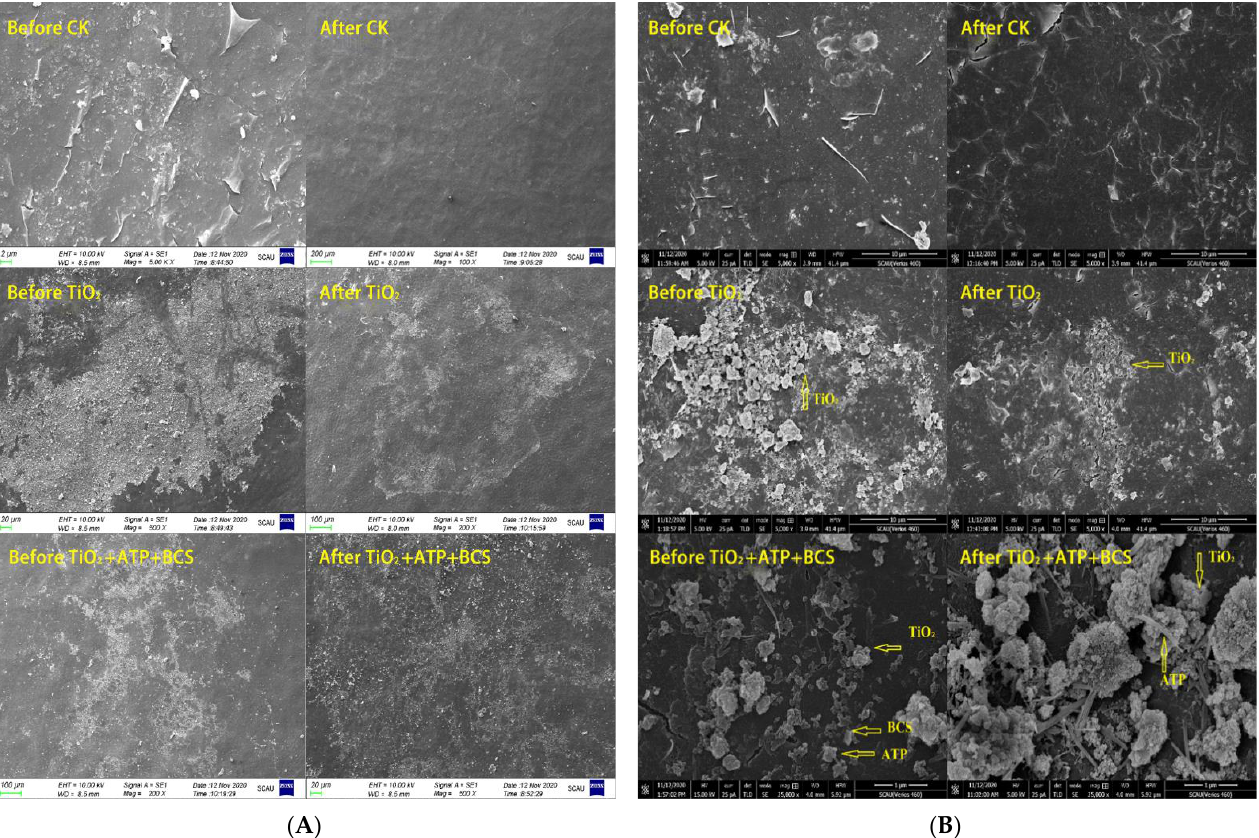
Figure 7. The blade of the nTiO 2 composite reagent distribution. ( A ): 500× or less; ( B ): 5000× or more; Before CK: Before CK spun; After CK: After CK spun; Before TiO 2 : Before nTiO 2 spun; After TiO 2 : After nTiO 2 spun; Before TiO 2 + ATP + BCS: Before nTiO 2 composite reagent spun; After TiO 2 + ATP + BCS: After nTiO 2 composite reagent spun.